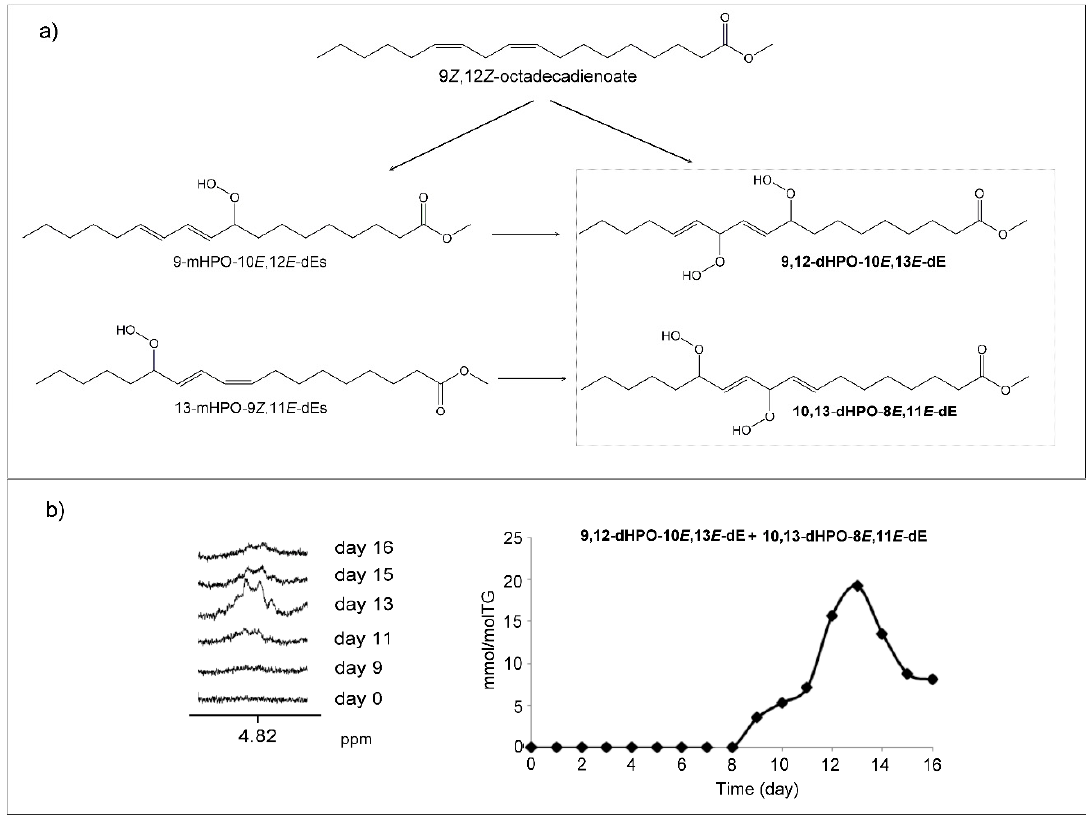
Figure 3. ( a ) Pathways of formation of dihydroperoxy-non conjugated dienes (dHPO-nc-dEs) proposed by some authors under certain oxidation conditions [50,54]. ( b ) Enlargements of the spectral region where changes occur throughout the accelerated storage process and their evolution with time, together with the graphical representation of the evolution of the concentration of 9,12-dHPO-10 E ,13 E -dE + 10,13-dHPO-8 E ,11 E -dE, expressed as mmol / mol TG, versus time given in days.